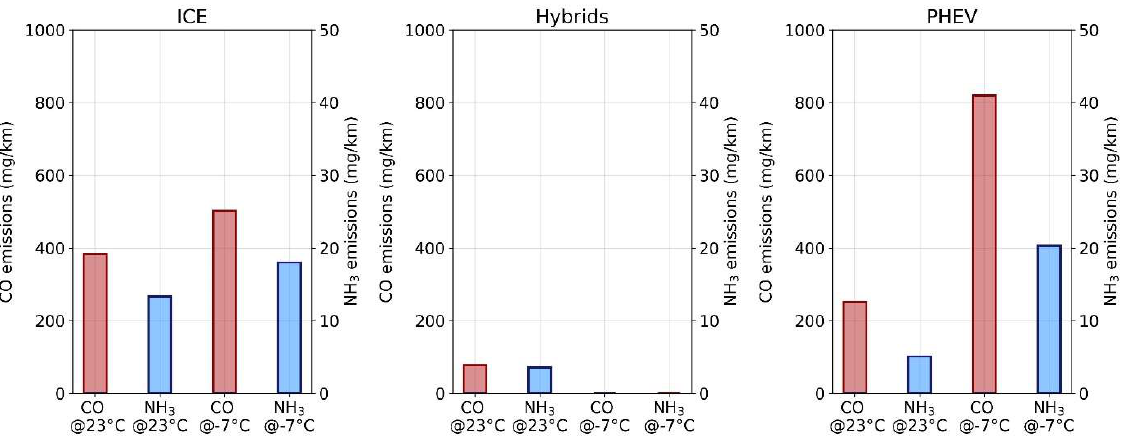
Figure 3. Bar plots of average NH 3 and CO on the WLTC at 23 °C and at −7 °C for the different engine technologies.